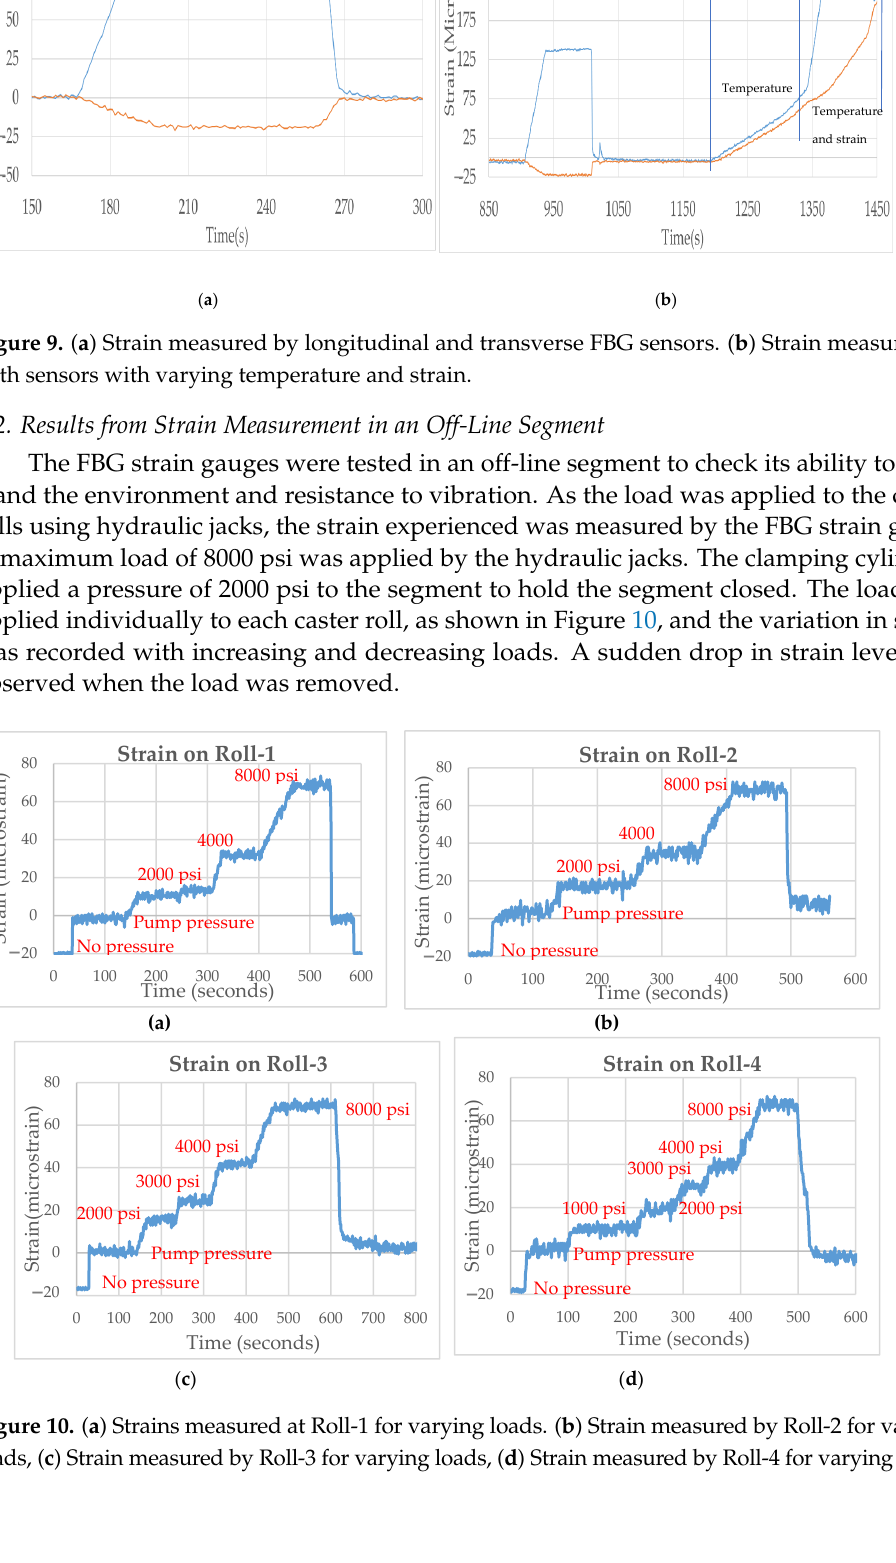
both sensors with varying temperature and strain.